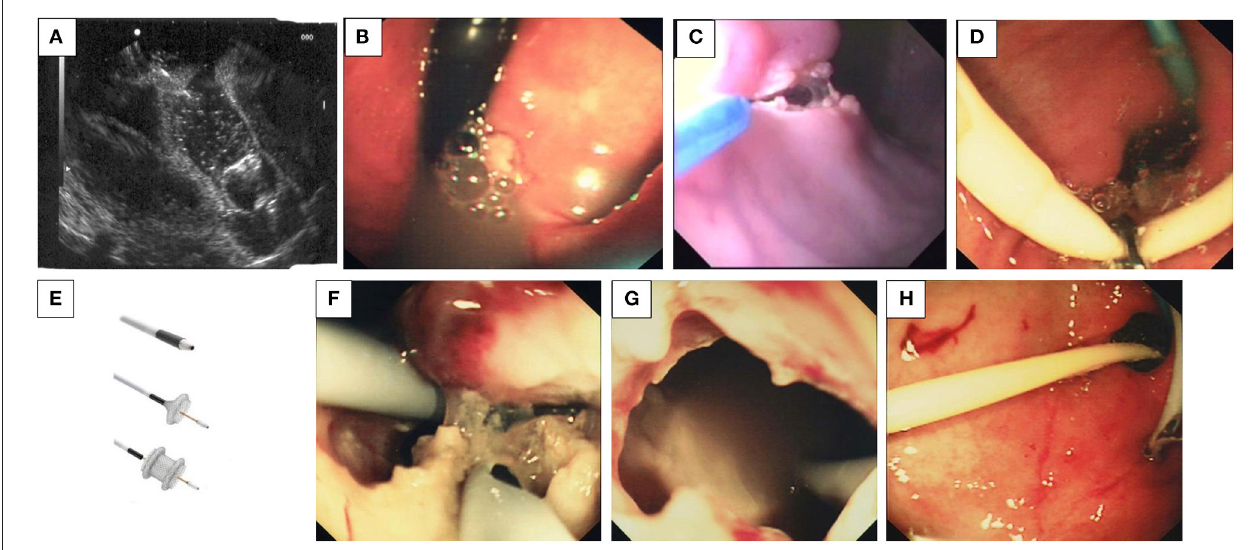
FIGURE 12 | (A–H) Drainage of pancreatic pseudocysts. (A) Trans-gastric linear endo-ultrasound needle puncture of a pancreatic pseudocyst. The linear needle can be seen as a straight white line in the upper part of the picture. (B) The indentation into the gastric wall can be seen easily identifying the position of the pseudocyst. (C) Creation of a cauterized entry from the stomach into the cyst by using and endoknife and sphincterotome: After endo-ultrasound has identified the cyst and a site which is free from gastric vessels, an endoknife followed by a sphincterotome (tapertome is best) is used to create a cauterized entry point from the stomach in to the cyst. Adrenaline can be injected prior to the incision to further diminish the possibility of hemorrhage during incision. (D) Grasping forceps are used to manipulate the stents [pig-tailed (blue) or straight (white)] through the gastro-cystostomy that was created. (E) Self-expanding metal stents. (F) The stents are endoscopically observed in the pseudocyst, and membranes between loculations can be punctured as necessary. (G) The endoscope is withdrawn from the pseudocyst. (H) The endoscope is withdrawn from the stomach and the gastro-cystostomy is left in